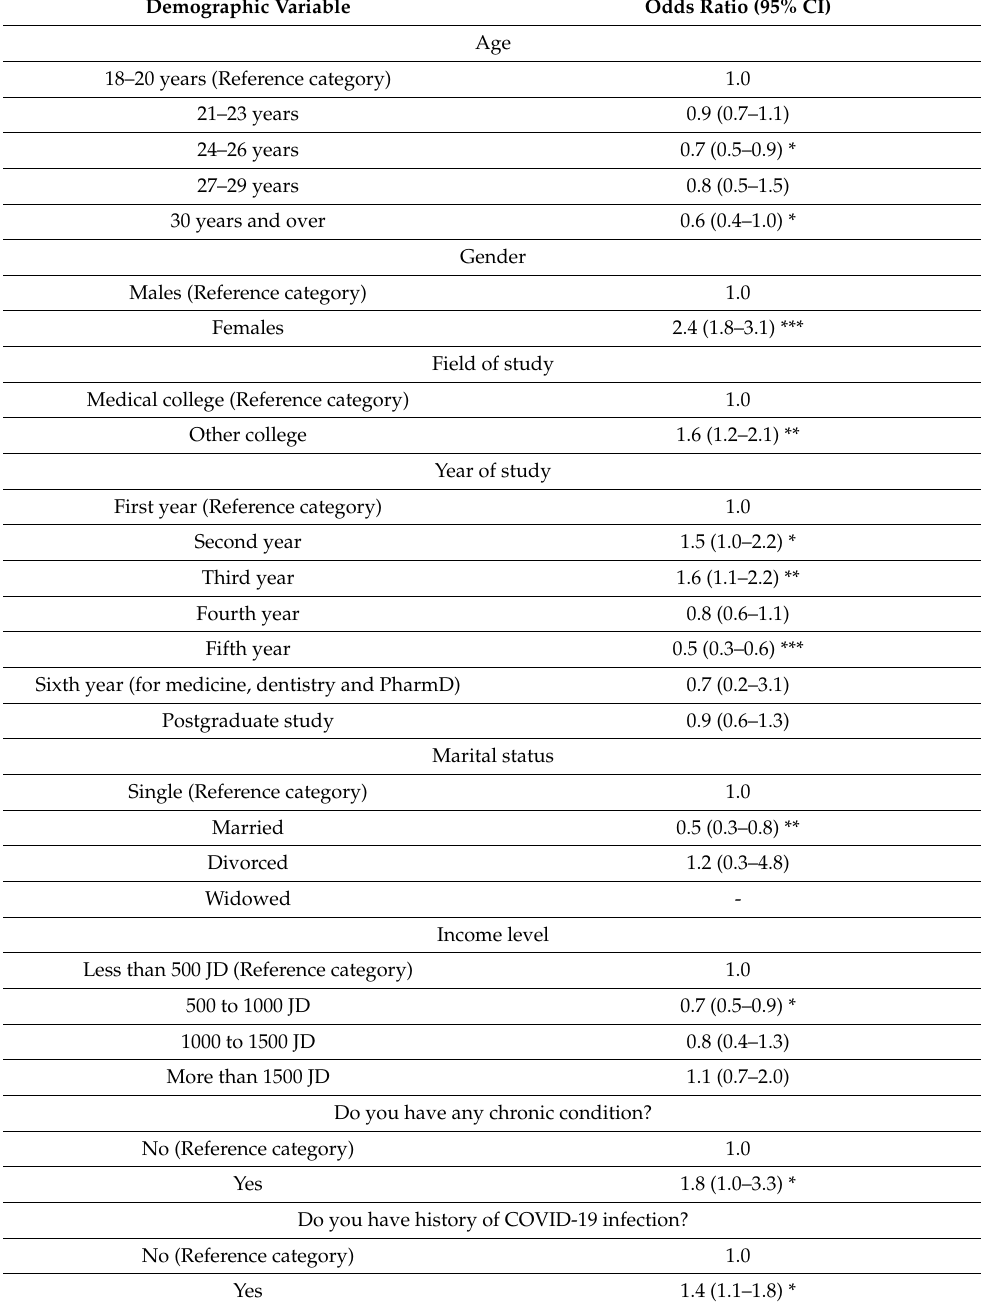
Table 4. Binary logistic regression